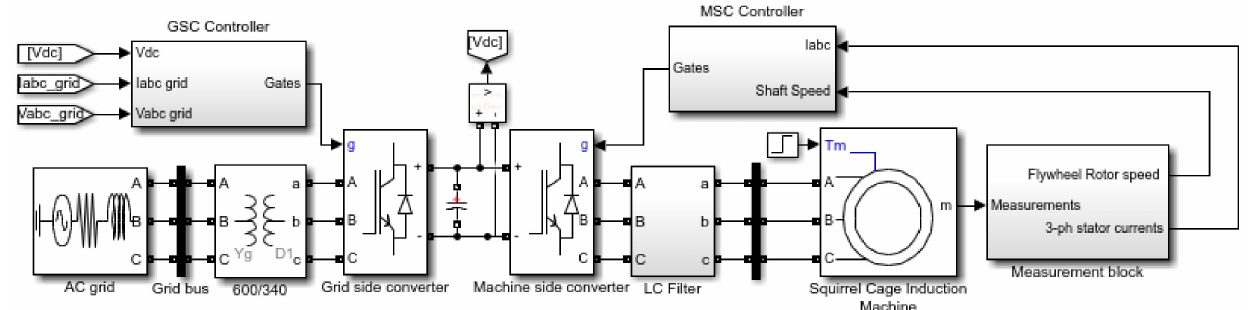
Figure 4. Simulink Model of